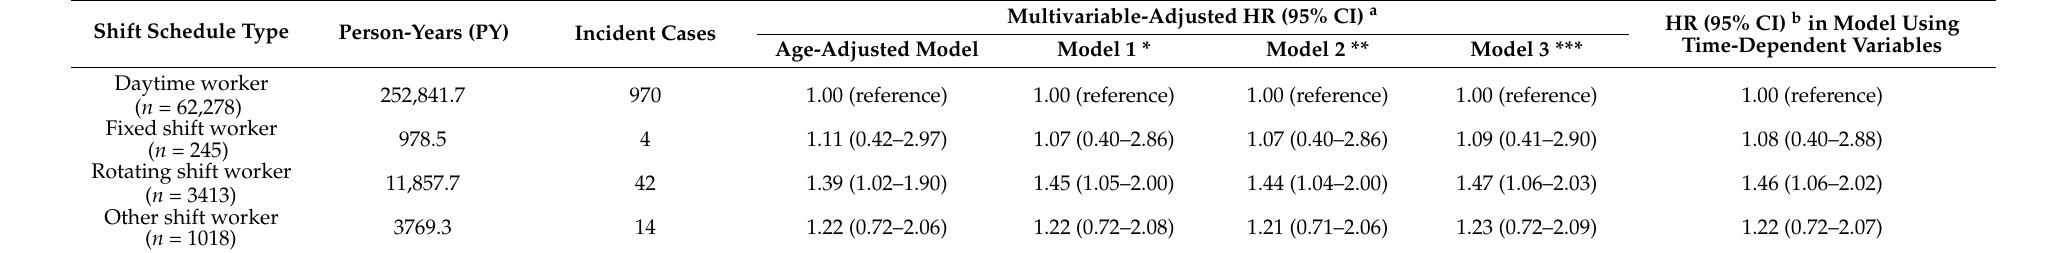
Table 3. Risk of elevated PSA according to shift schedule type.